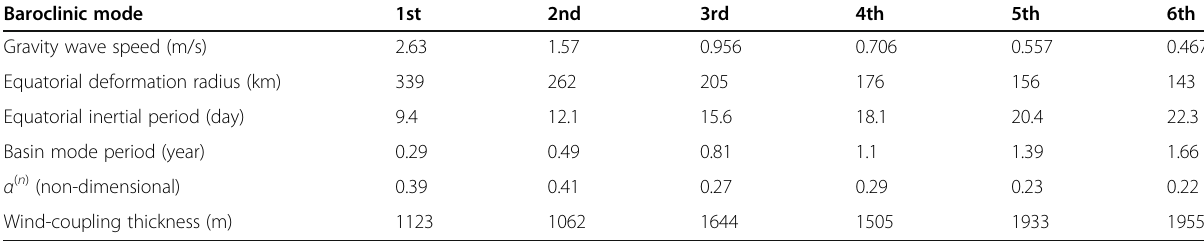
Table 1 List of experiment parameters. The basin mode period is defined as 4 L / c ( n ) where L = 6110 km is the zonal distance of the Indian Ocean at the equator (from 45 to 100 ° E). The wind-coupling thickness is defined